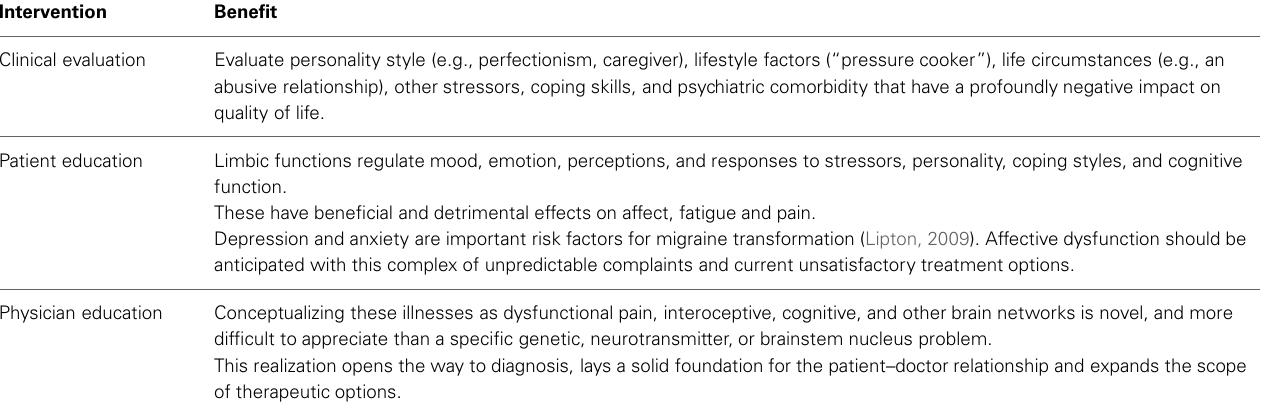
Table 5 | Approach to patients with overlapping migraine, GWI, CFS, FM, and other disorders (adapted from Maizels et al., 2012). Intervention Benefit Clinical